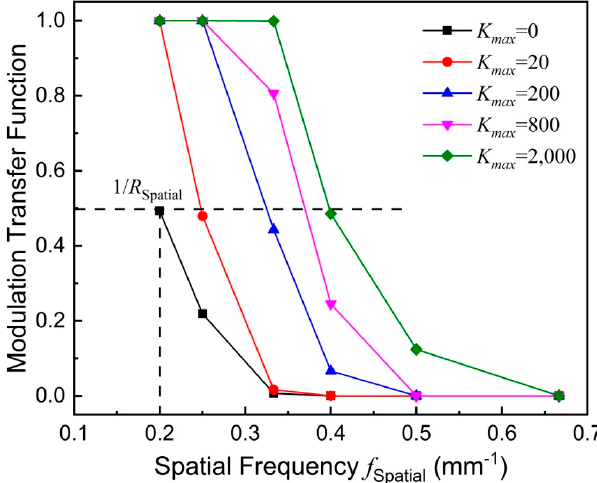
Figure 6. Modulation transfer function versus spatial frequency for different K max values. Symbols represent experimental results whereas solid lines are guides to the eye.